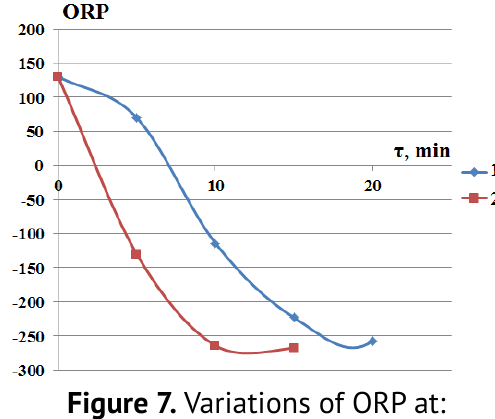
Figure 7. Variations of ORP at: 1 - j =10mA/cm 2 ; 2 - 20mA/cm 2